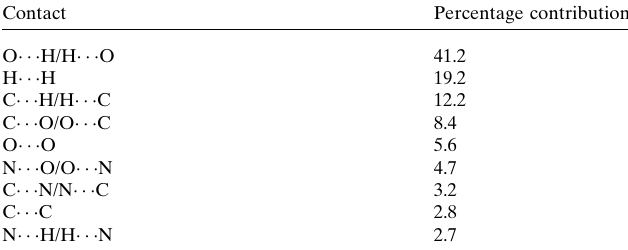
Table 3 Percentage contributions of interatomic contacts to the Hirshfeld surface for the title compound.